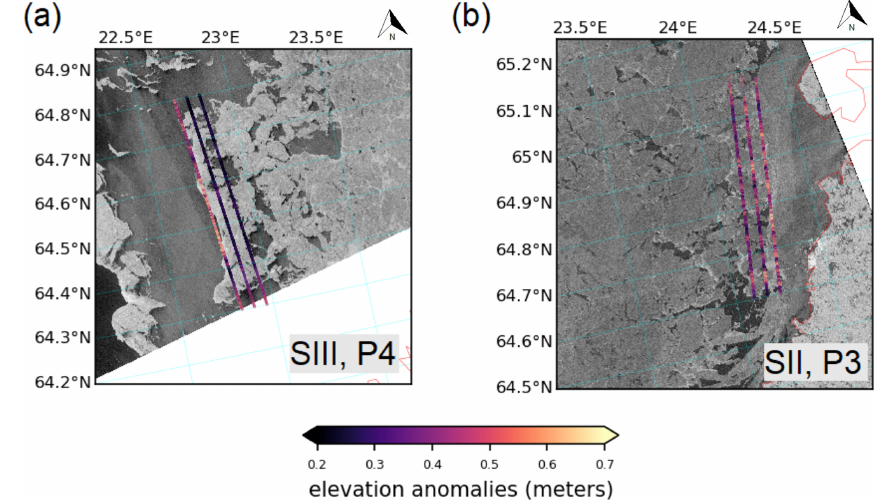
Figure 8. (a) S1 C-band SAR image (SIII, HH polarisation) acquired on 17 February 2019 with elevation anomalies from IS2 overlaid, 8h 5min between acquisitions. Similar to Fig. 6a but with different SAR polarisation. (b) S1 C-band SAR image (SII, HH polarisation) acquired 23 March 2019 with elevation anomalies from IS2 overlaid, 2h 26min between acquisitions. Similar to Fig. 6b but with different SAR polarisation.